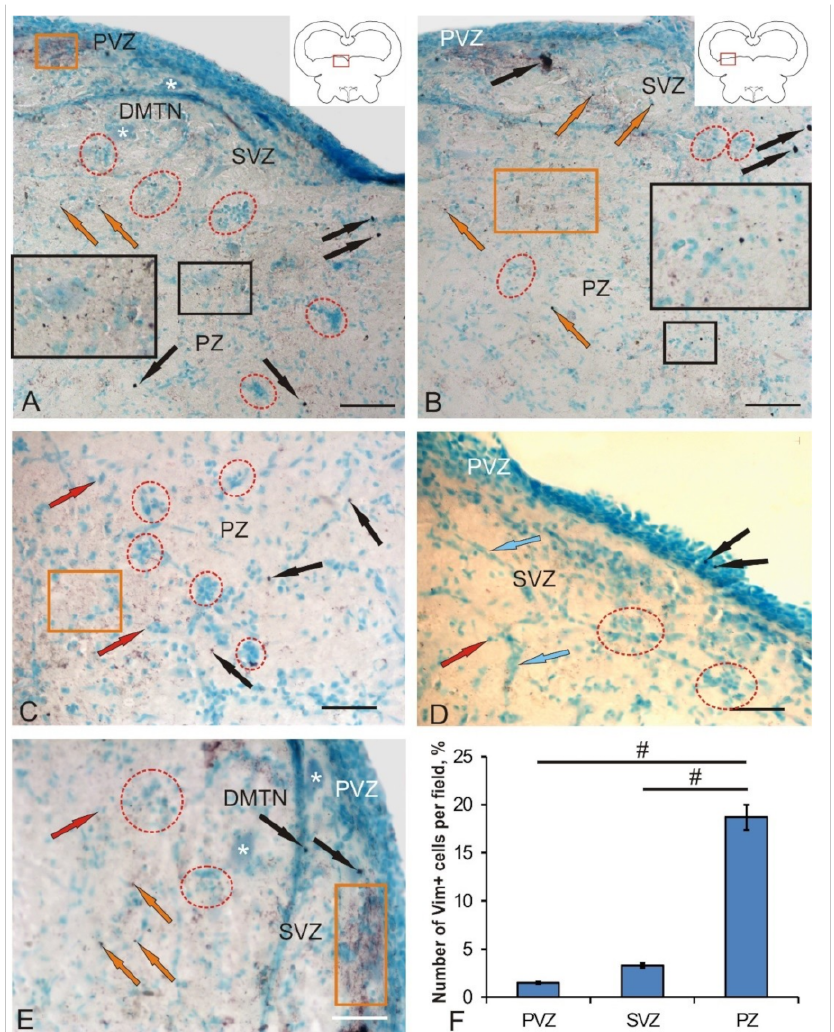
Figure 5. Localization of vimentin in the mesencephalic tegmentum of juvenile chum salmon, Oncorhynchus keta . ( A ) In the medial tegmentum: Vim + cells (black arrows), Vim + granules (orange arrows), and large neurons in DMTN indicated by white stars, areas of extracellular deposition of vimentin (in an orange rectangle), and constitutive neurogenic niches with Vim– cells (outlined by red dotted lines); Vim + granules localized both inside cells and in the intercellular space are outlined by black rectangle (inset). ( B ) In the lateral tegmentum (designations as in Figure 5A). ( C ) In the parenchyma of tegmentum: Vim– cells (red arrows). ( D ) In PVZ and SVZ: accumulations of Vim– cells along vessels (blue arrows). ( E ) In DMTN: a dense zone of extracellular deposition of vimentin is outlined by an orange rectangle. IHC vimentin labeling in combination with methyl green staining. ( F ) The ratio of Vim + cells in various areas of tegmentum in control groups ( n = 5 in each group; # means significant intergroup di ff erences); one-way analysis of variance (ANOVA). Scale bar: (A,B) = 100 µ m; (C–E) = 50 µ